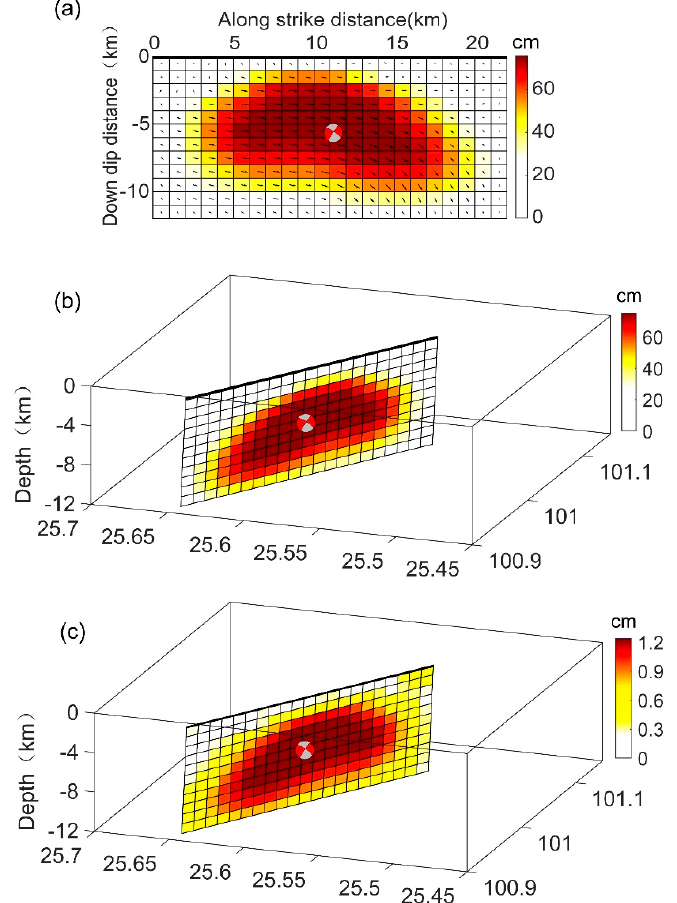
Figure 6. ( a ) Slip distributions for a fault plane of 22 km length, 12 km downdip width, and 87° dip; ( b ) 3-D view of the fault from WSW; ( c ) 1 σ uncertainty in fault slip estimated through a Monte Carlo process with 100 inversions. The thick black line in the top of each subfigure represent the projection of fault trace on the surface.